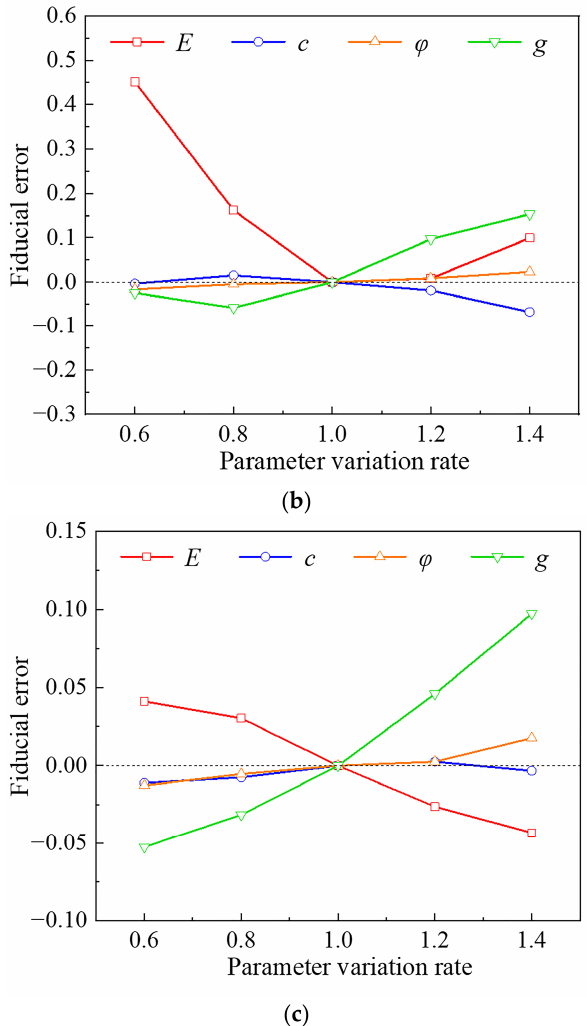
Figure 6. Acceleration limit value error curve. ( a ) L1; ( b ) H1; ( c ) H2.